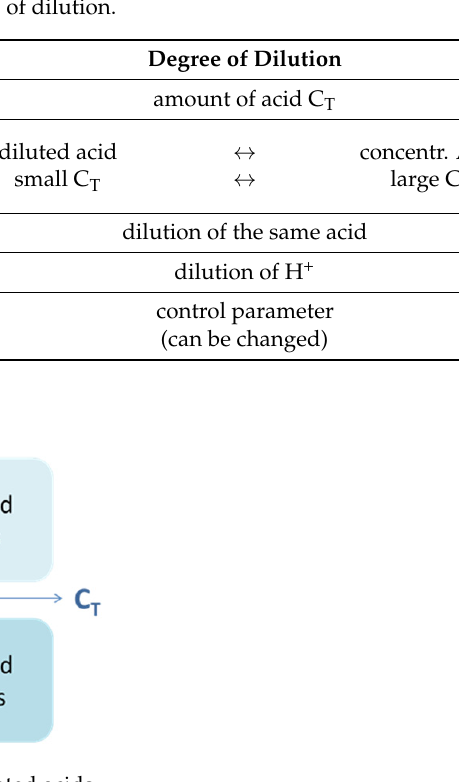
Figure 25. Weak/strong vs. diluted/concentrated acids.